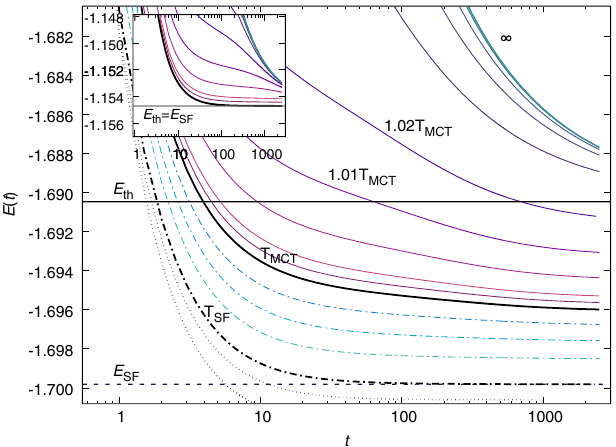
FIG. 3. Energy relaxation in the ( 3 þ 4 )-spin model, starting from different temperatures T and quenching to zero temperature. Solid lines are quenches from the ergodic phase ( T ≥ T MCT ¼ 0 . 805166 ); from bottom to top, T=T 1 , 1.001, 1.002, MCT ¼ 1.005, 1.01, 1.02, 1.05, 1.1, 1.2, 1.5, 2, 4, 10, ∞ . Dashed- dotted lines correspond to quenches from temperatures T 0 . 9914 T 0 . 798 ≤ T < T ; from top to bottom, SF ¼ MCT ¼ MCT T=T 0 . 998 , 0.996, 0.994, 0.992, and at T . Dotted lines MCT ¼ SF 0 . 99 , 0.988). We clearly see correspond to T < T ( T=T SF MCT ¼ small enough, although larger than T . Inset: Same dynamics MCT ); the energy never goes for the three-spin model ( T ≥ T MCT below threshold.